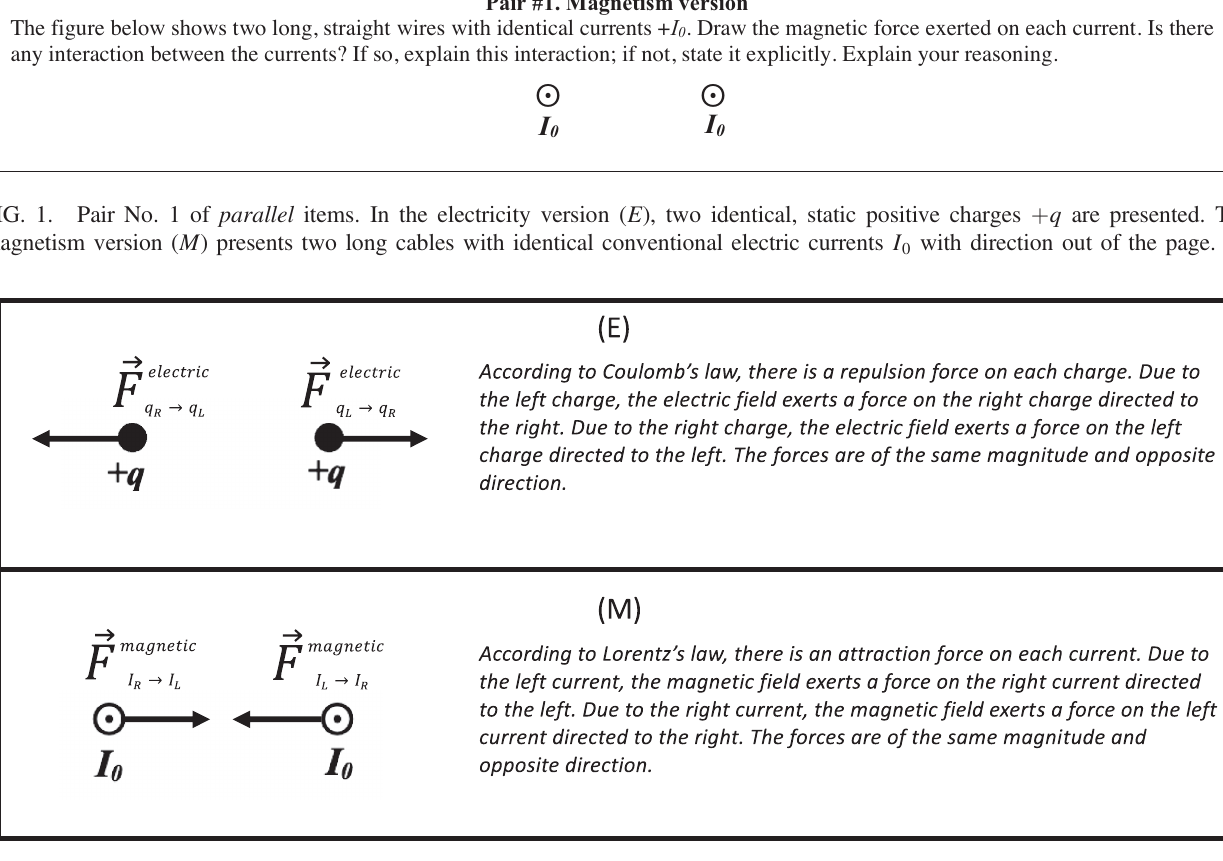
FIG. 2. Expected answer for the pair No. 1 of parallel items. On the top, the expected diagram and reasoning for the electricity version ( E ); on the bottom, the expected diagram and reasoning for the magnetism version ( M ).